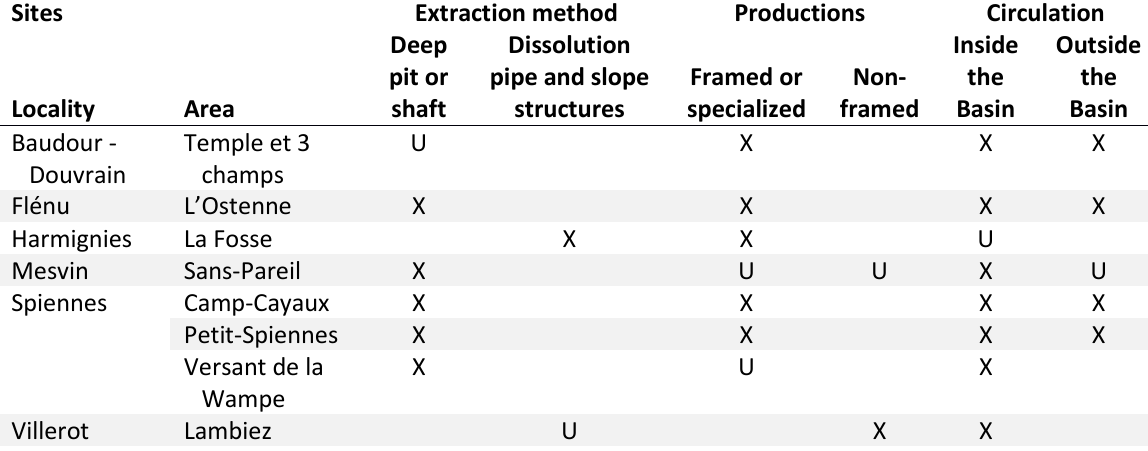
Table 2. Characterisation of extraction sites in the Mons Basin. Abbreviations: X - attested elements; U - elements which remain to be